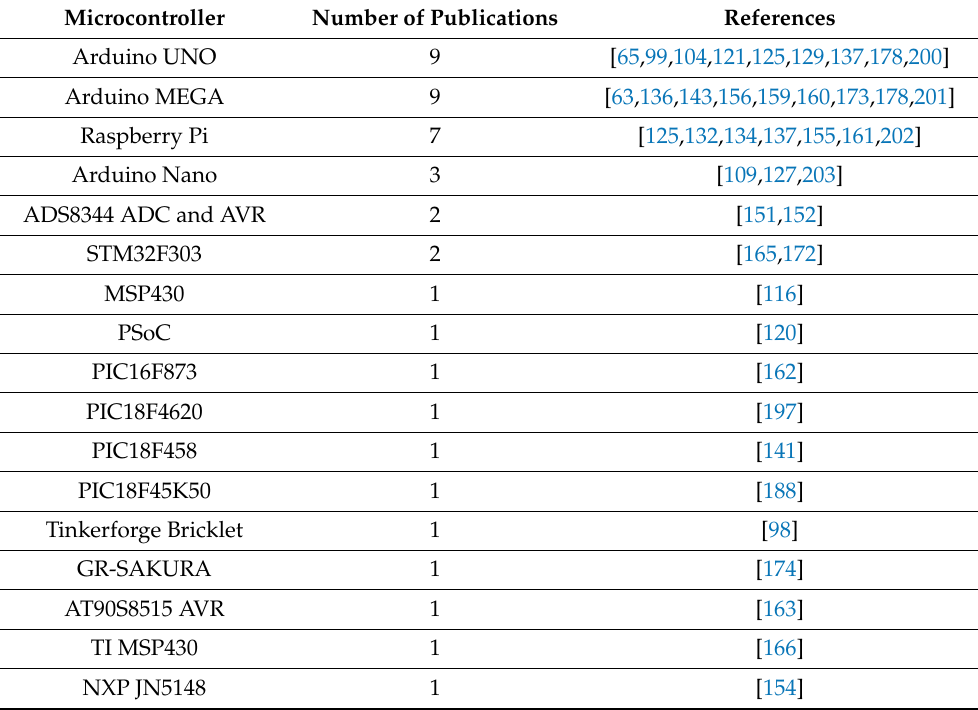
Table 4. List of the microcontrollers used in SCOPUS database for low-cost building monitoring.